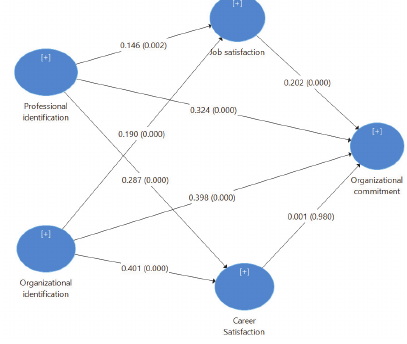
Fig. 4. Hypothesis test results without regulatory variables (Bootstrap out Smart